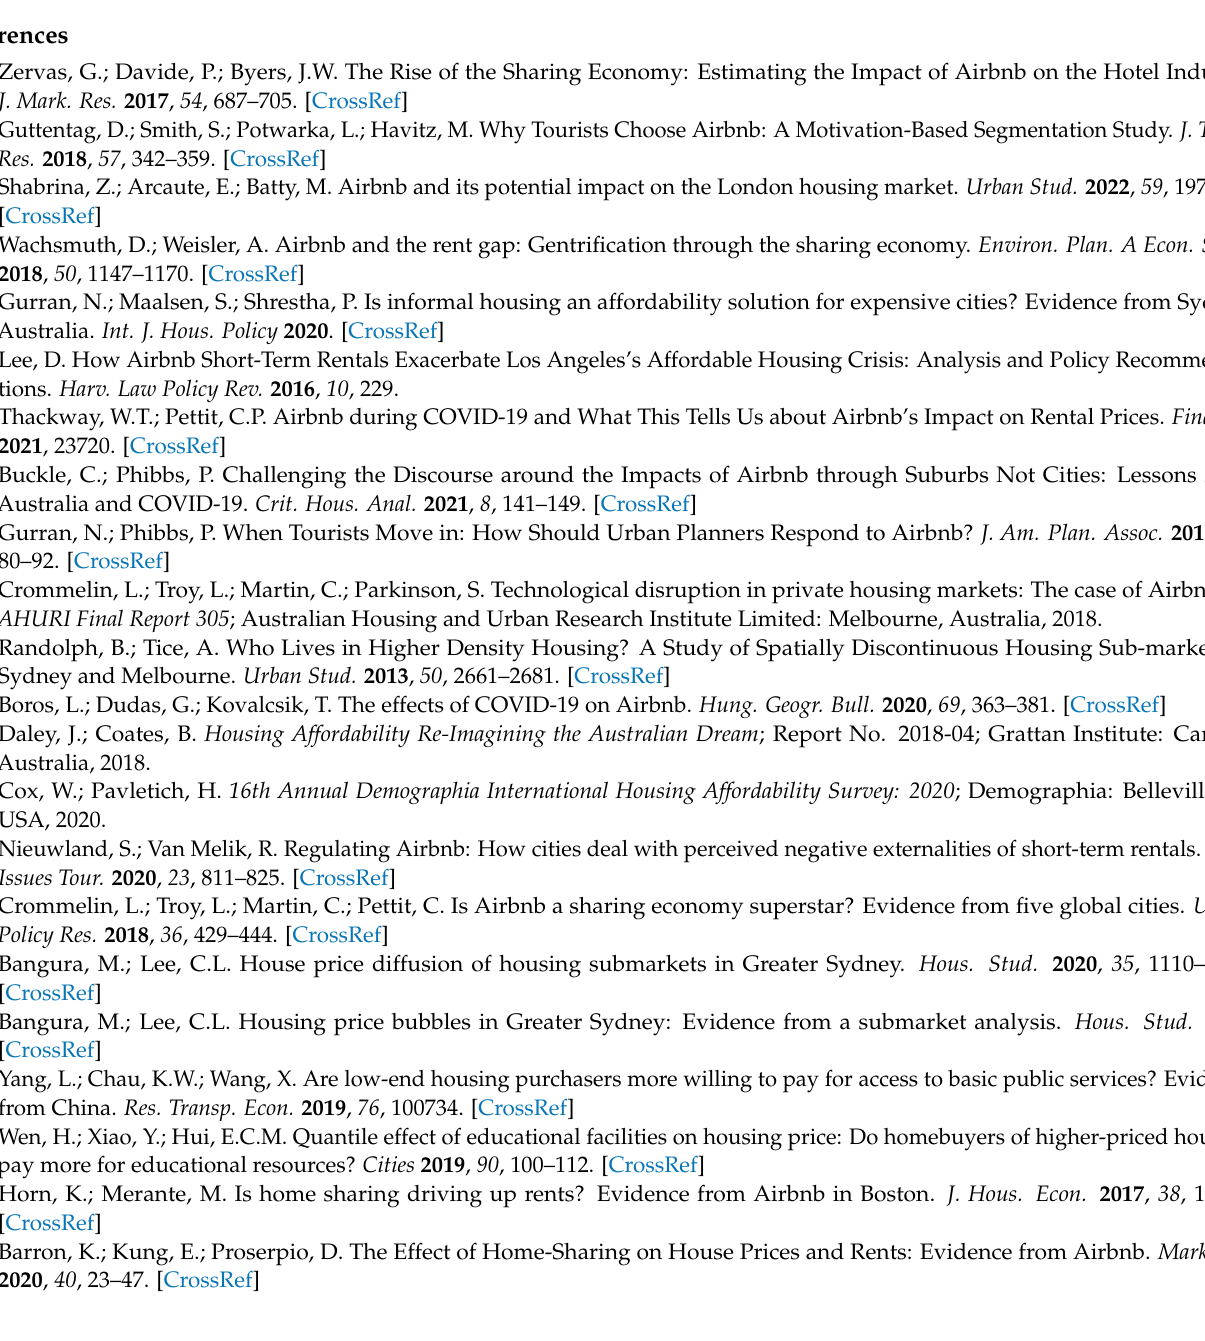
Figure A1. Spatial kernel types (Fotheringham et al., 2003).